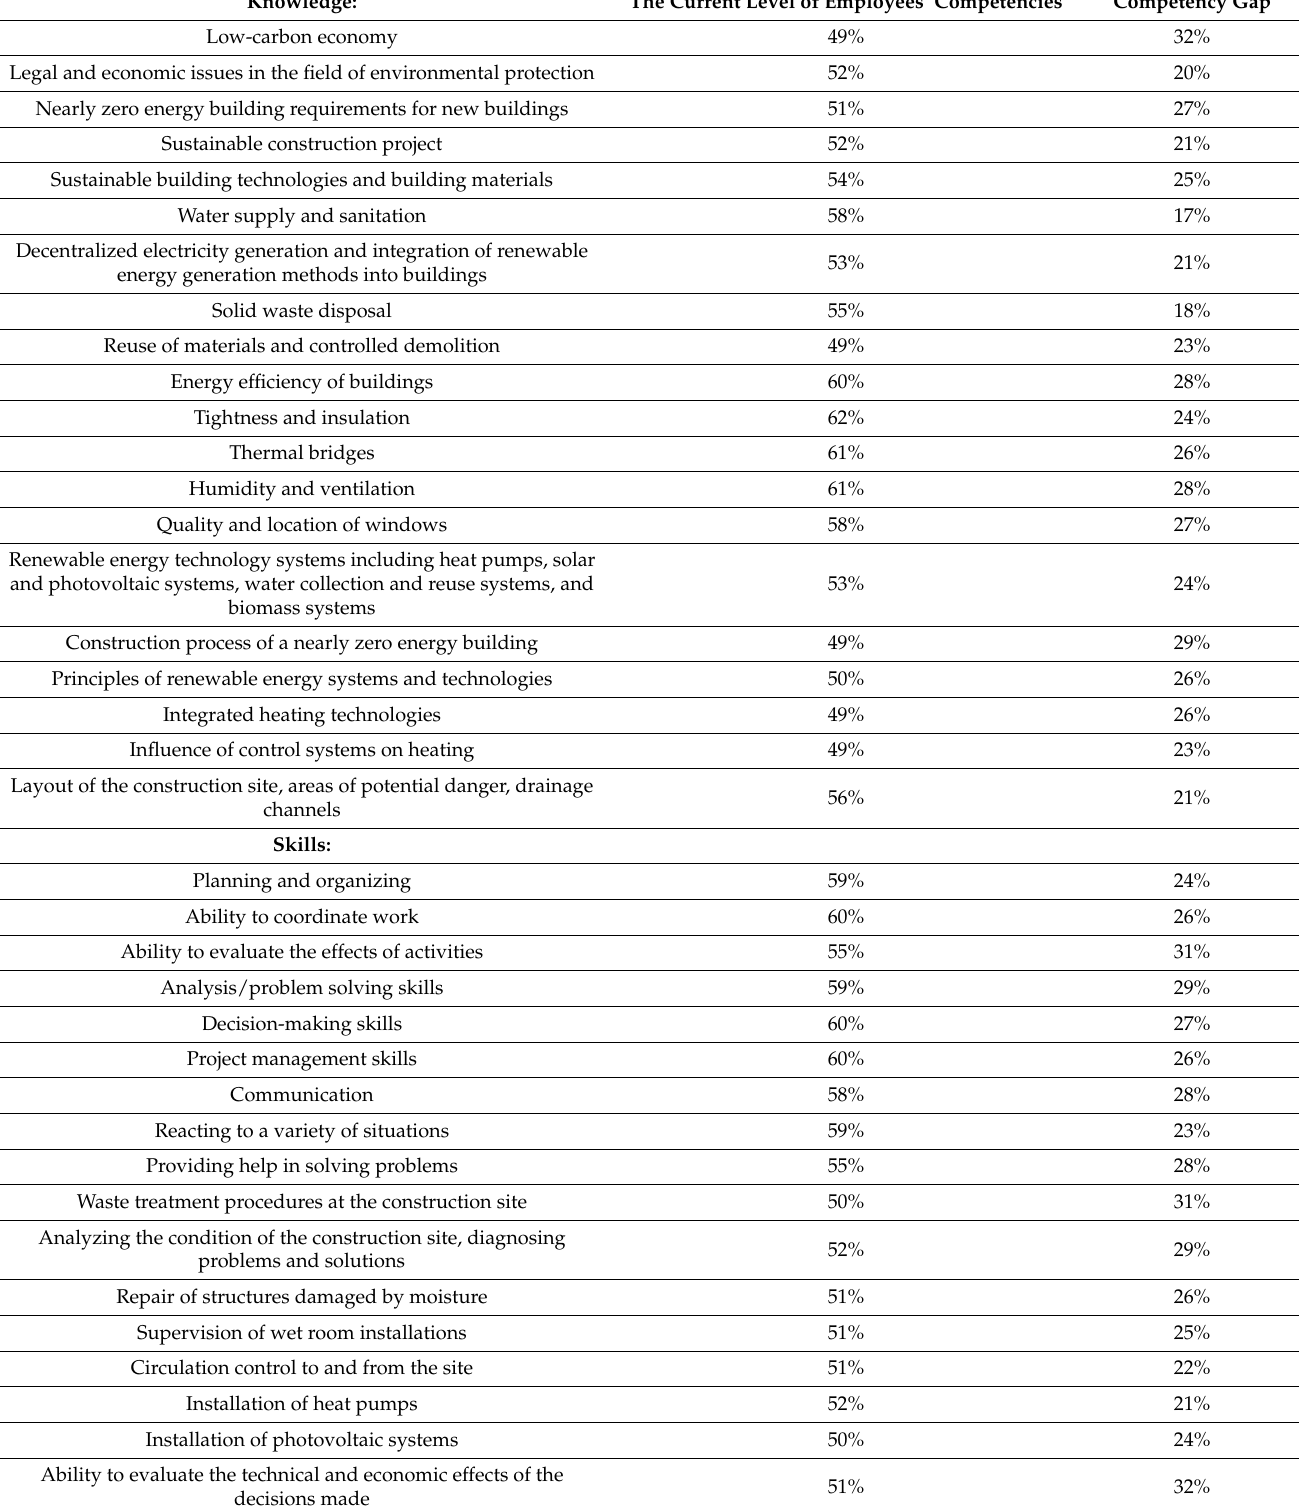
Table 4. Competency gap of employees in the construction industry in